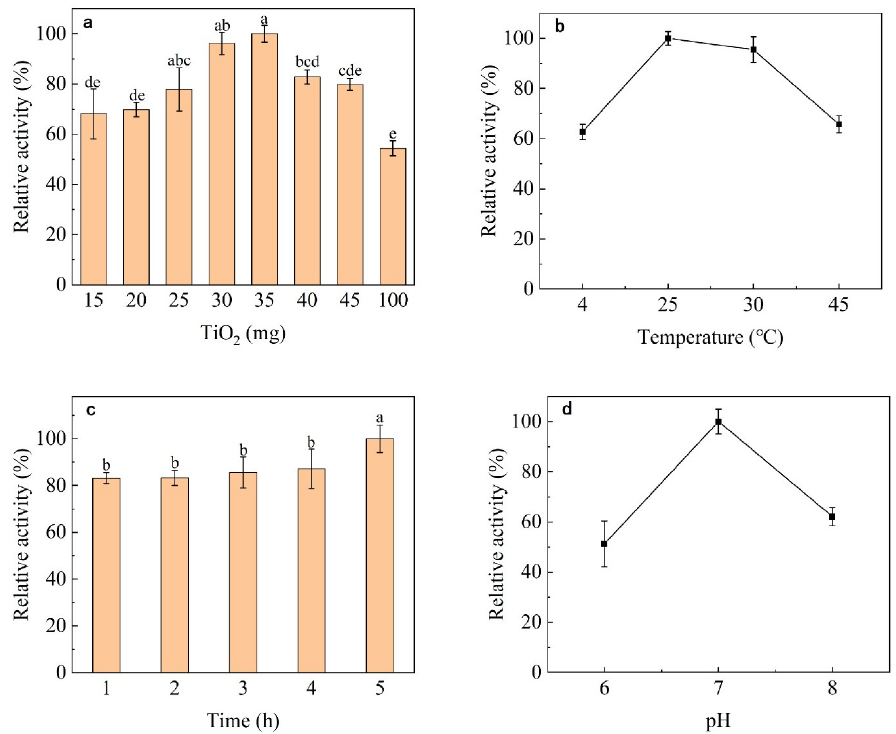
Figure 2. Effect of different conditions on enzyme immobilization: ( a ) TiO 2 content, ( b ) temperature, ( c ) time and ( d ) pH. On the bar chart, the different lowercase letters show that there are significant difference ( p >